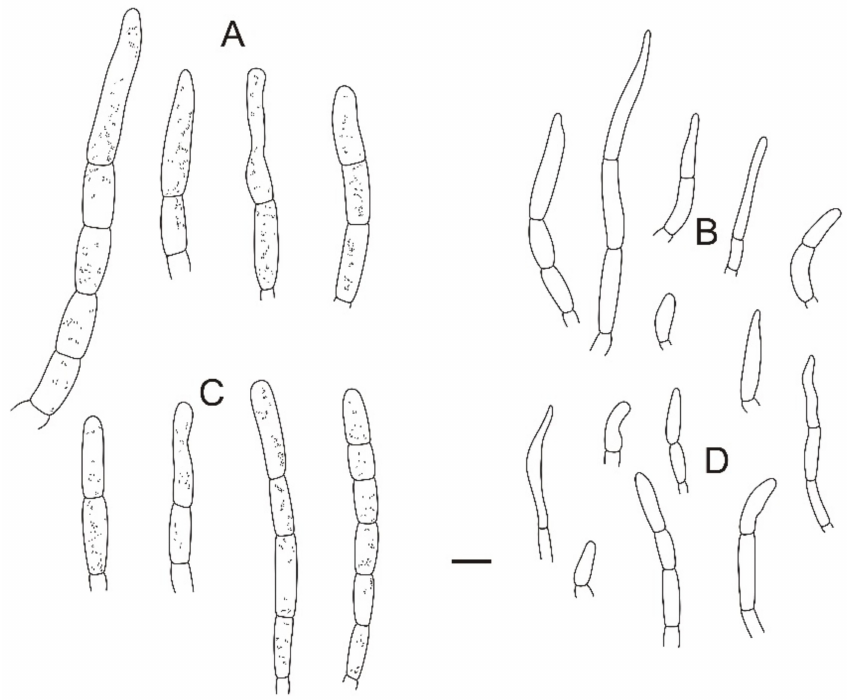
Figure 13. Microscopic features of Russula sinoparva (BJTC ZH441). ( A ) Pileocystidia near the pileus margin. ( B ) Hyphal terminations near the pileus margin. ( C ) Pileocystidia near the pileus center. ( D ) Hyphal terminations near the pileus center. Scale bar: 10 µ m. MycoBank: MB